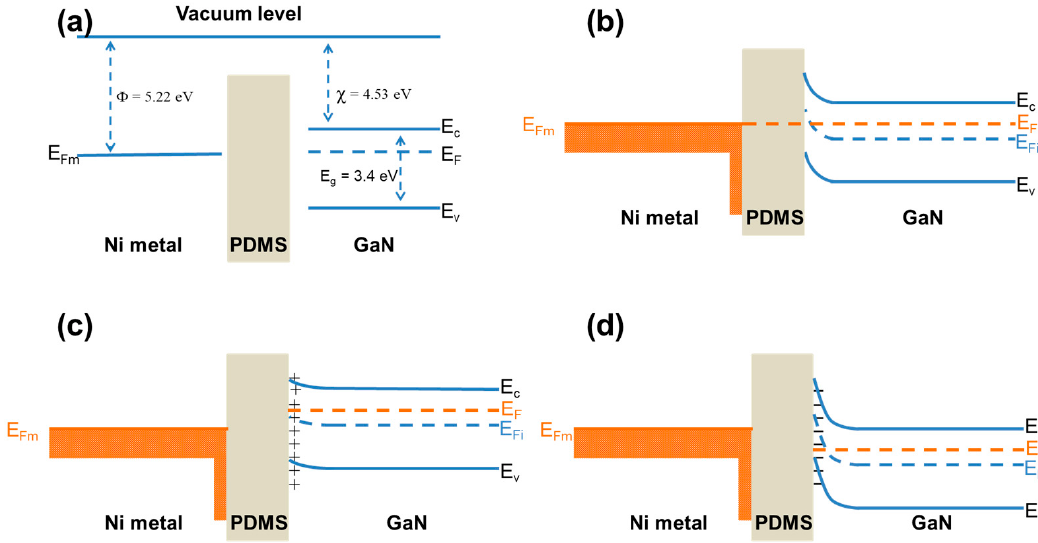
Figure 5. Schematic illustration of energy band diagram of Ni-PDMS-GaN ( a ) band positions of GaN and work function Ni in vacuum before contact; ( b ) metal-dielectric-semiconductor (MDS) interface in thermal equilibrium; ( c ) the effect of positive piezoelectric charges on band bending of GaN at PDMS-GaN interface; and, ( d ) formation of negative charges when the stress was relieved and their effect on band bending of GaN at PDMS-GaN interface. Φ —work function, χ —Electron affinity, E F —Fermi level, E Fi —Intrinsic Fermi level, E g —bandgap, E c —lower level of conduction band, E v —upper level of valance band, E Fm —metal fermi level.